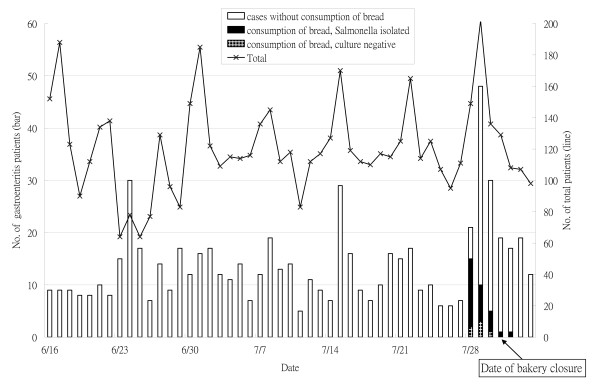
Case number of attendees of the ER due to all causes (line) and due to gastroenteritis (bar) 6 weeks before the outbreak and during the outbreak week. Cases consuming the kind of bread with and without Salmonella isolated in late July and early August, 2001 were indicated in different bars.